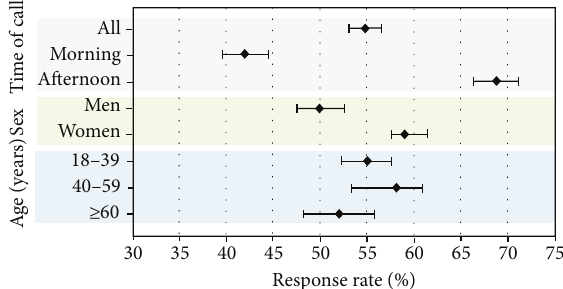
Table 2: Intensity of the mass media campaign in each